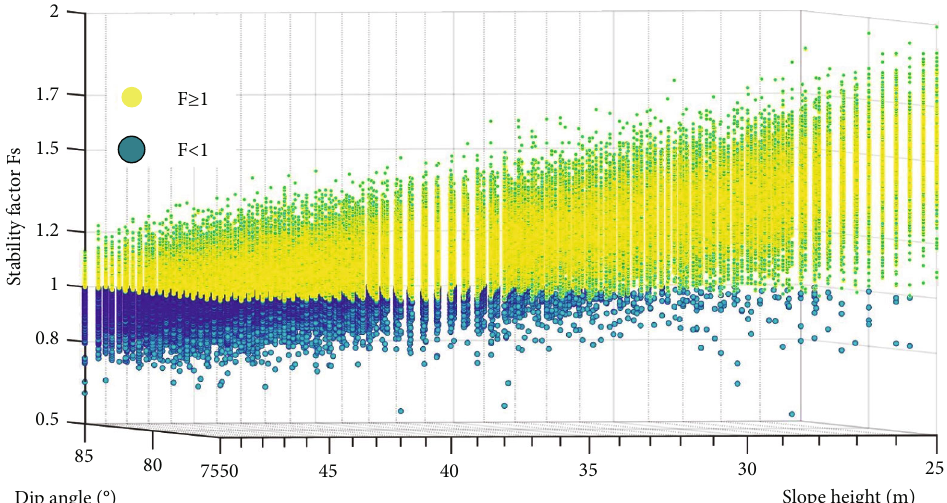
Figure 16: Statistical chart of stability coe ffi cient under di ff erent combinations of slope height and slope angle.